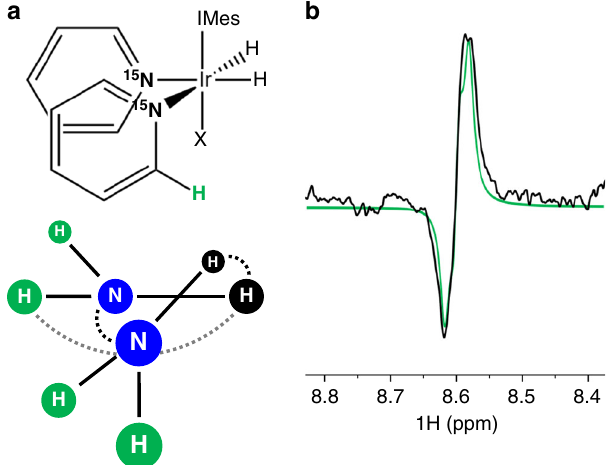
Fig. 4 Prediction of the ortho- 1 H resonance lineshape after 25 ms DARTH pulse. a Chemical system and magnetic structure used in the simulation along with its dominant homonuclear (dashed, black) and heteronuclear (solid, black) J couplings, as well as the long-range 4 J HH coupling (dashed, gray). b Experimental specrrum (black) along with fi t (green) from QMC